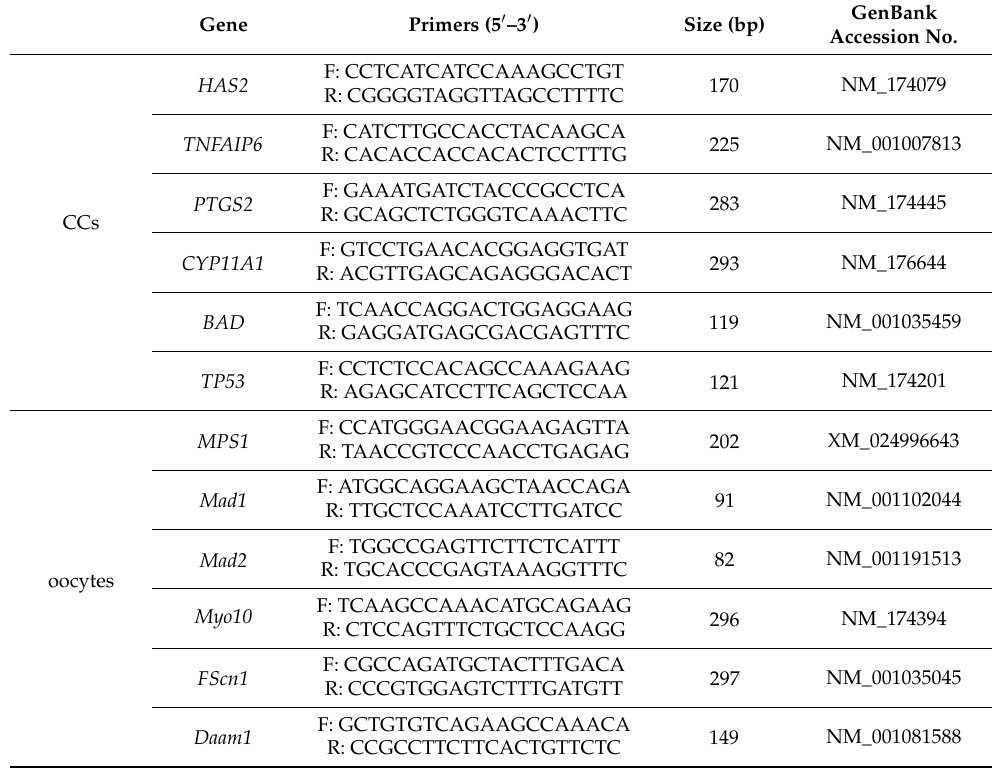
Table 1. Primers used for qRT-PCR of candidate genes in CCs, oocytes, and blastocysts. Gene Primers (5 (cid:48) –3 (cid:48)